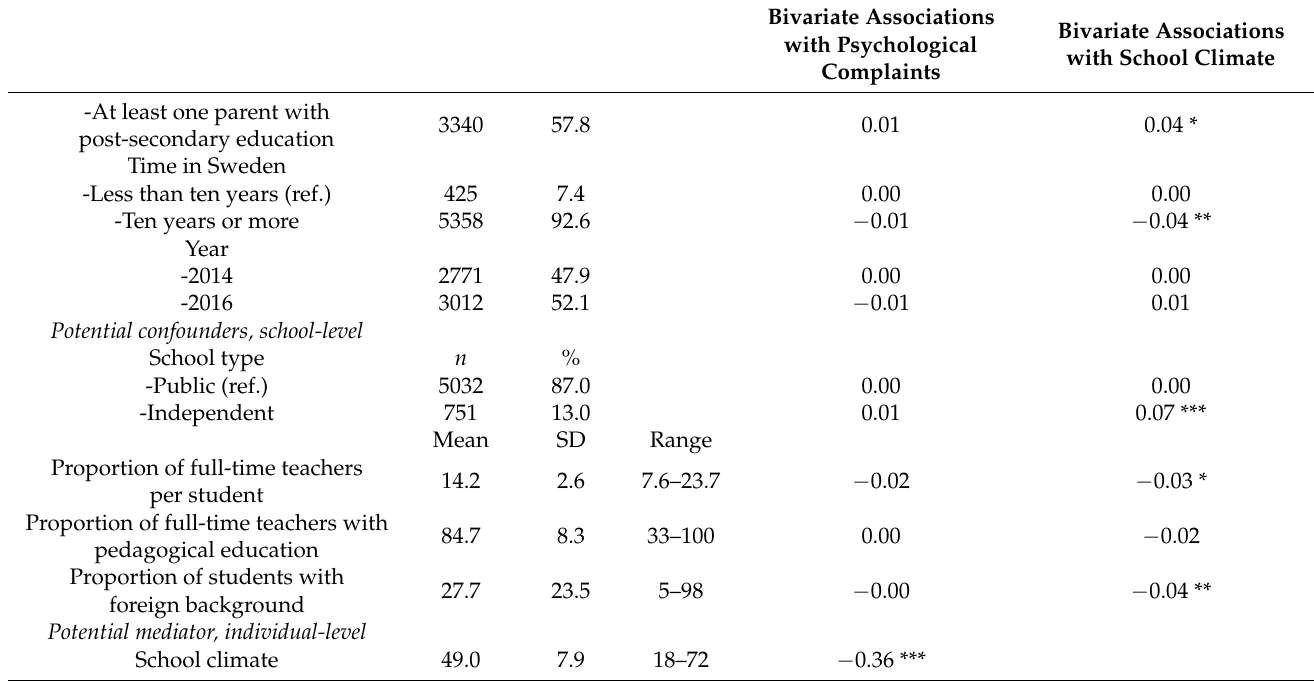
Table 2. Cont. Bivariate